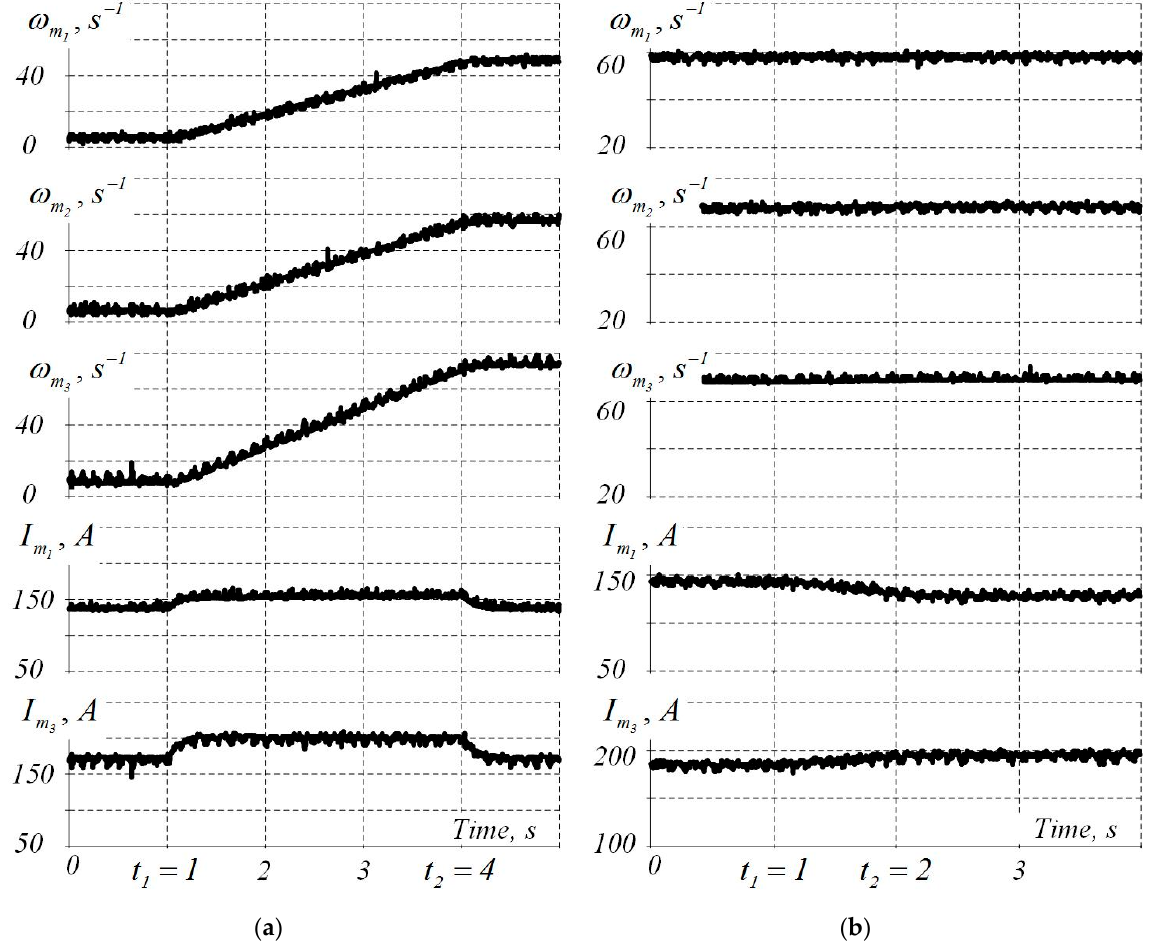
Figure 15. Results of experimental studies during acceleration ( a ) and when changing the setting of critical angles in the first and third deformation centers ( b ).